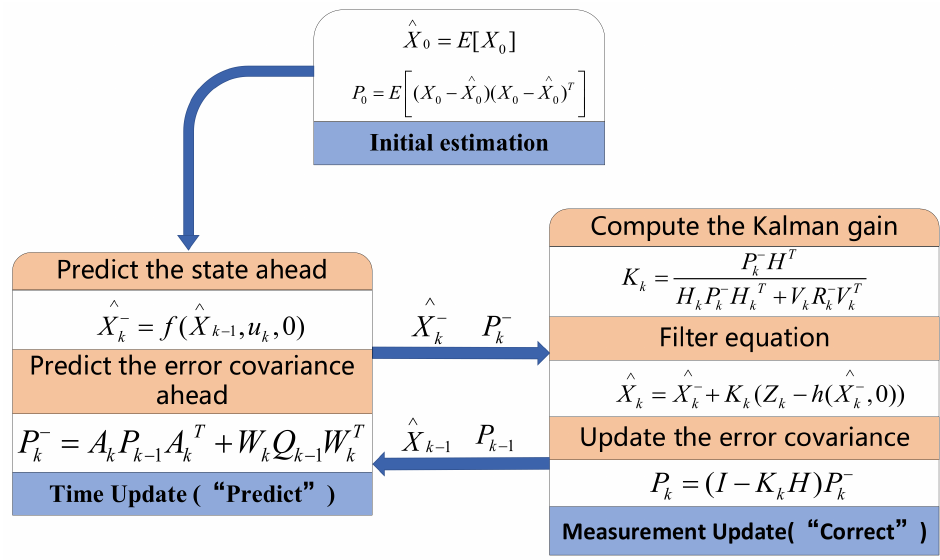
Figure 4. The procedures of the EKF